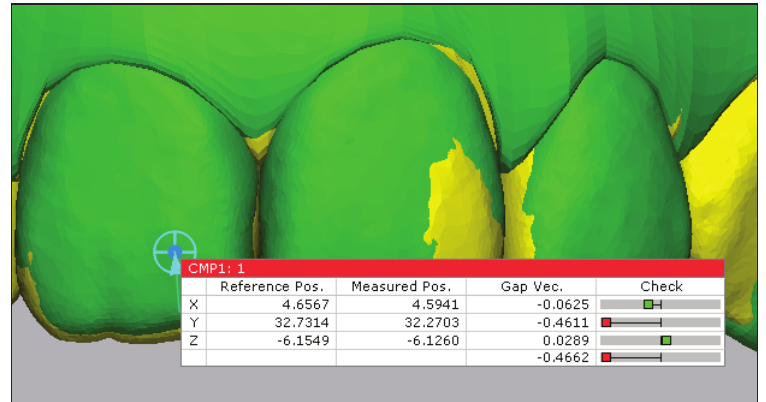
Figure 10. The displacement of the point selected in Figure 9 above can also be checked in three dimensions using the Point Comparison method demonstrated in Figure 4, allowing determination of the actual displacement.